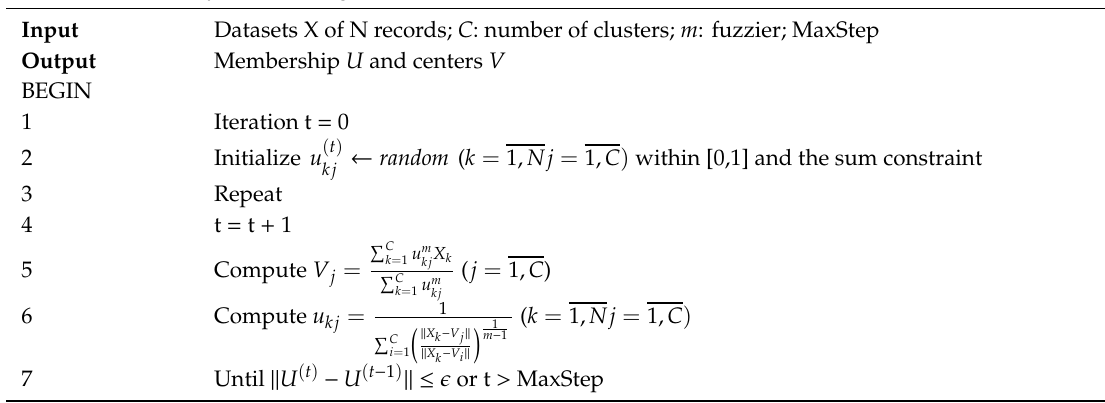
Algorithm 1. Fuzzy C-Means